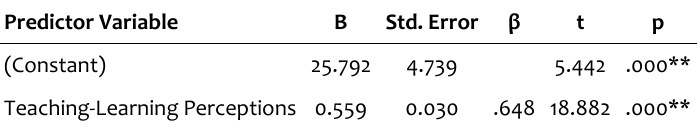
Table 3: Prediction Level of Teachers’ Teaching-Learning Perceptions of the Pedagogical Competence Perceptions